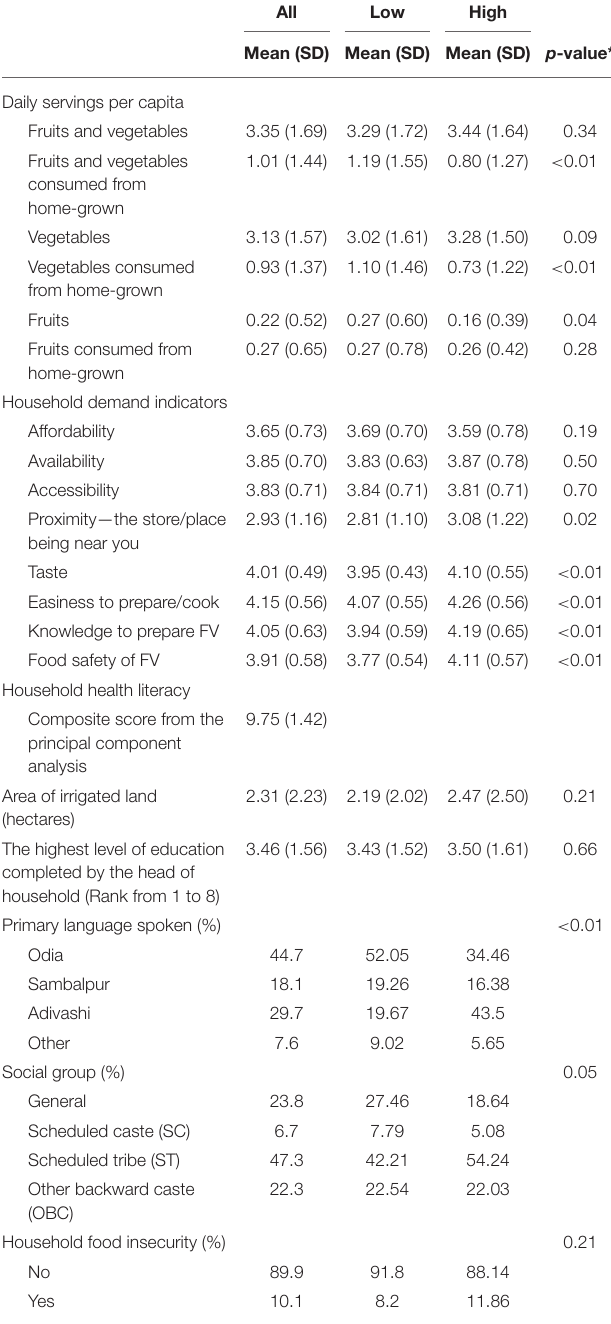
TABLE 1 | Descriptive information for all, low-, and high-health literacy groups. All Low